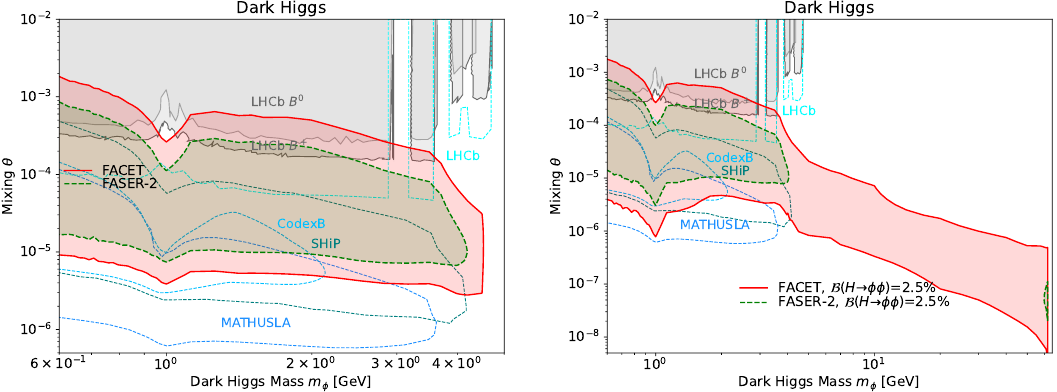
Figure 6 . Reach of FACET and other existing and proposed experiments for a dark Higgs boson φ (3 event contours) with the assumption of either 0% (left) or 2.5% (right) branching fraction for the H (125) → φφ decays. In the second scenario, FACET offers a unique coverage all the way to half m H for a range of mixing angles. FACET and FASER-2 contours are calculated with Foresee [38]. Current exclusions from LHCb [62, 63] are shown as gray shaded regions. Also, sensitivity